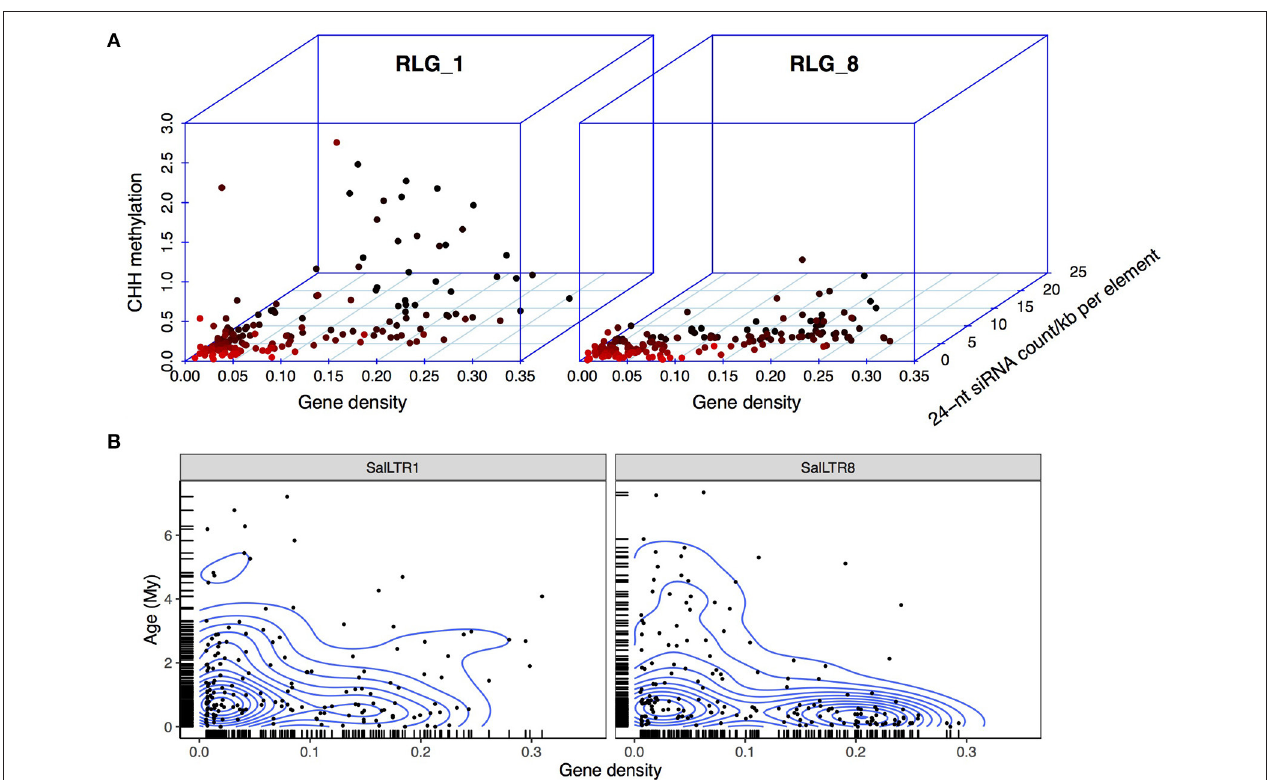
FIGURE 4 | Epigenetic repression and insertional locations of RLG_1 and RLG_8 in S. alba . (A) Correlations between CHH methylation level, 24-nt siRNA abundance of the RLG_1 and RLG_8 elements, and gene density of the 100Kb region in which each retroelement is located in the S. alba genome. Each dot represents an intact RLG_1 or RLG_8 element and is colored in red to black gradient according to gene density of the genomic region in which the element is located. (B) Age distribution of the RLG_1 or RLG_8 elements along genomic regions with different gene density. Contour lines represent estimated two dimensional kernel